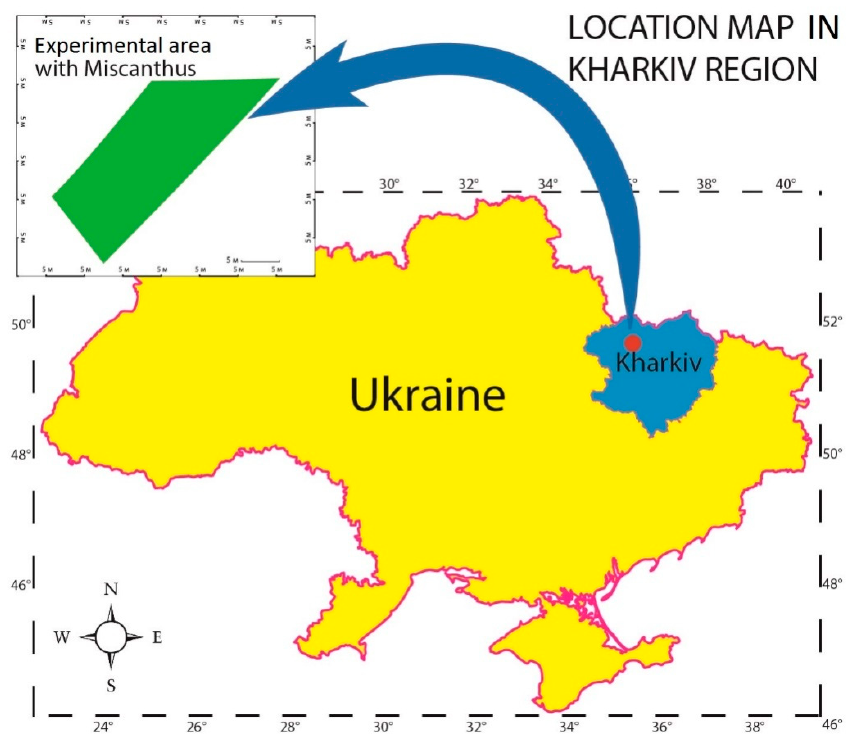
Figure 1. Experimental research area in Ukraine in Kharkiv region. Source: own elaboration.